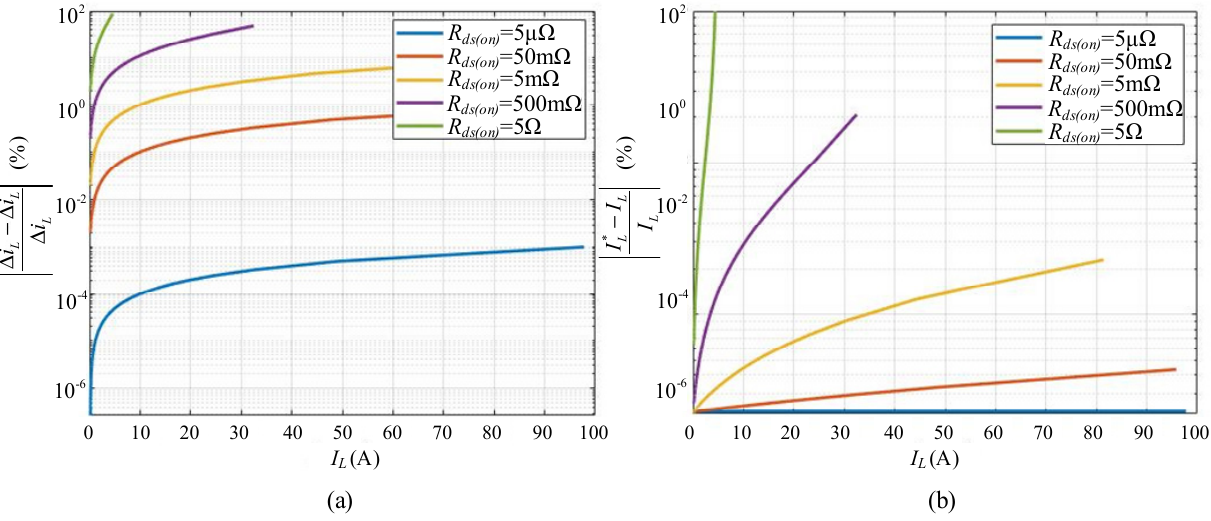
Figure 11. The error between the simplified and precise model: ( a ) the error of ∆ i L , and ( b ) the error of I L .